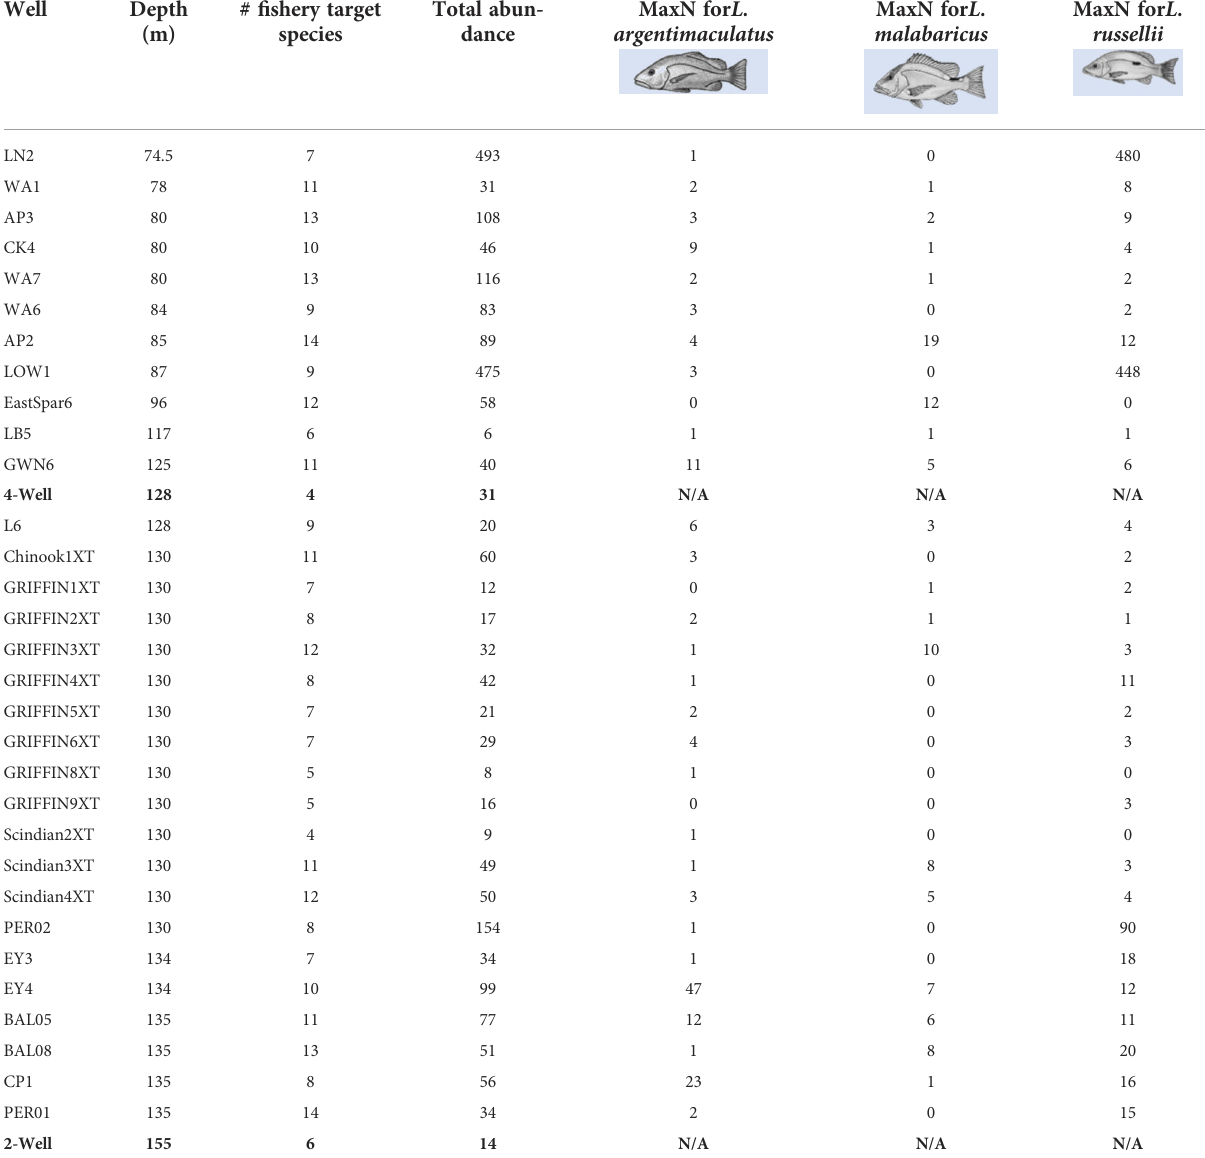
TABLE 3 Total relative abundance (sum of MaxNs) of all fi shery target species and three of the most common and abundant snapper (Lutjanus) species observed on remotely operated vehicle imagery of subsea wells. Well